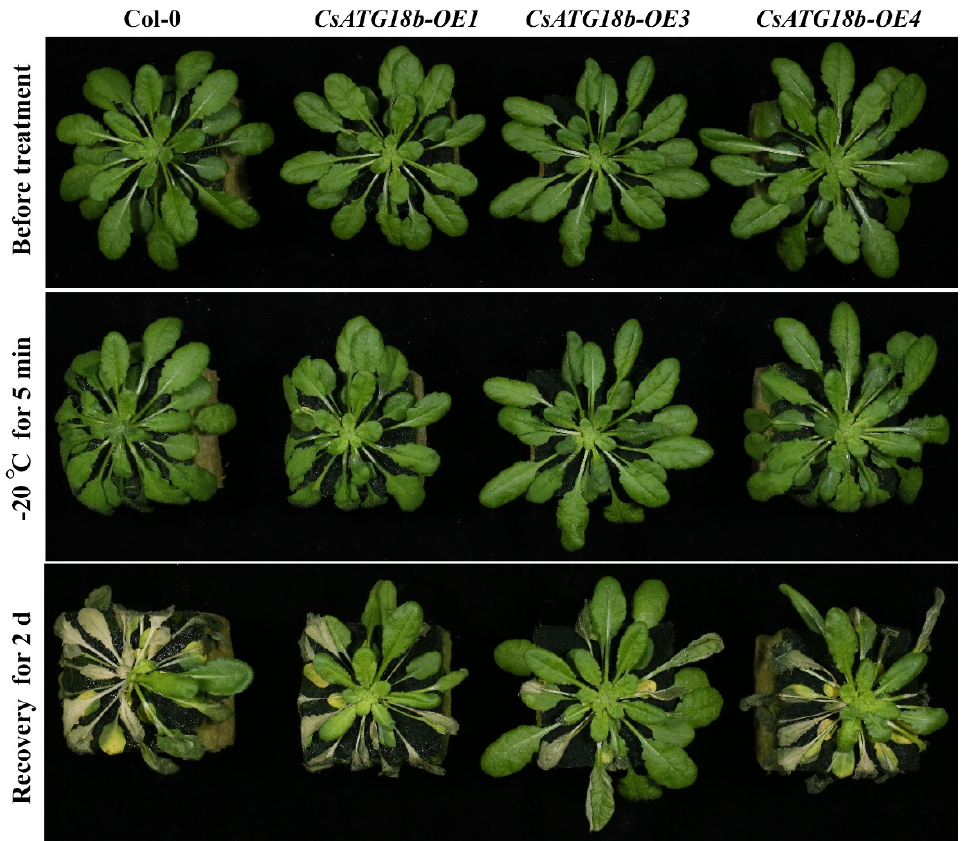
Figure 9. Overexpression of CsATG18b reduced leaf damage of transgenic Arabidopsis under cold stress. Representative pictures of WT and OE lines (OE1, OE3, and OE4) of CsATG18b were photographed before treatment, after -20°C for 5 min, and after recovery (25°C) for 2 days.